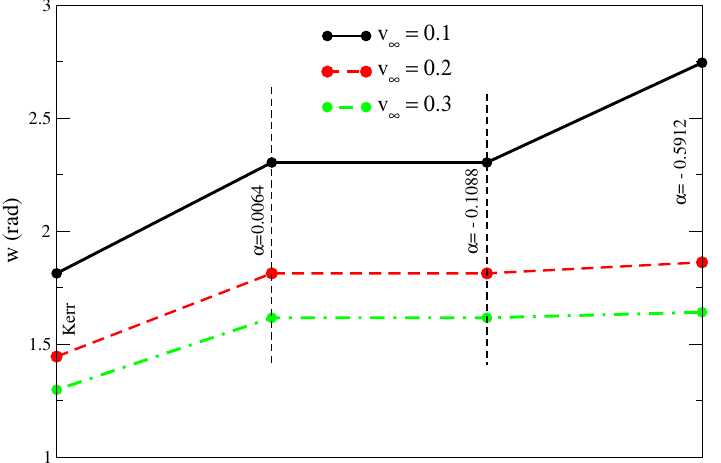
Figure 2. Cone width in terms of asymptotic velocity for Kerr and EGB black